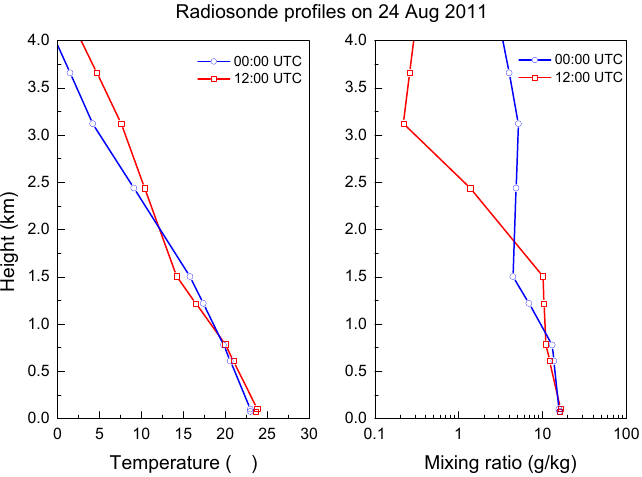
Figure 16. Temporal evolution of the extinction coefficient on 24 August